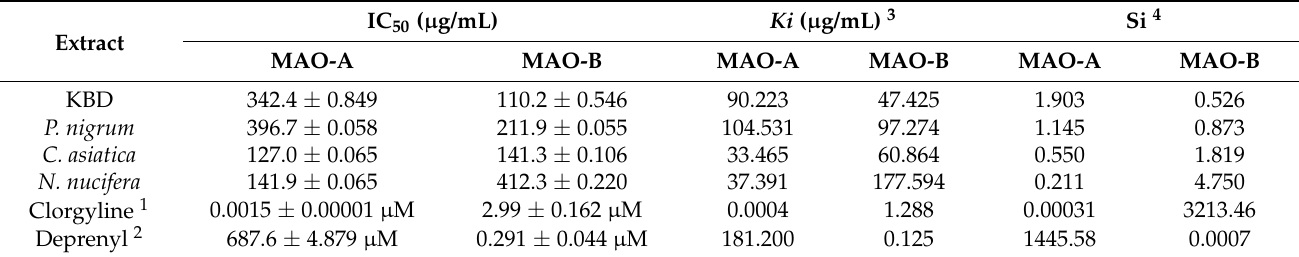
Table 1. Monoamine oxidase inhibitory activities of KBD formula and its component extracts.